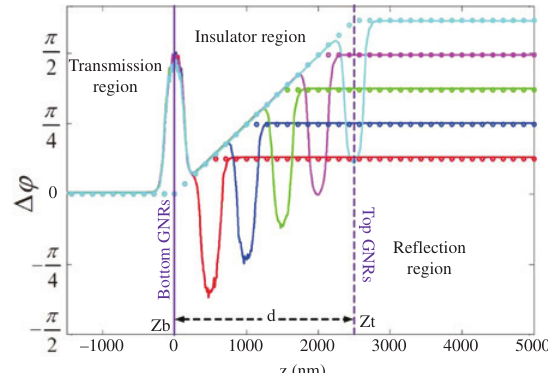
Figure 18: Linear spectra of absorption (A, dotted line), reflectance (R, continuous line), and transmittance (T, dashed line) of a crossed graphene polarizer calculated for three values of the incidence polarization angle: α = 0 (red lines), α = π /4 (blue lines), and α = π /2 (green lines). Reproduced from Ref. [280].